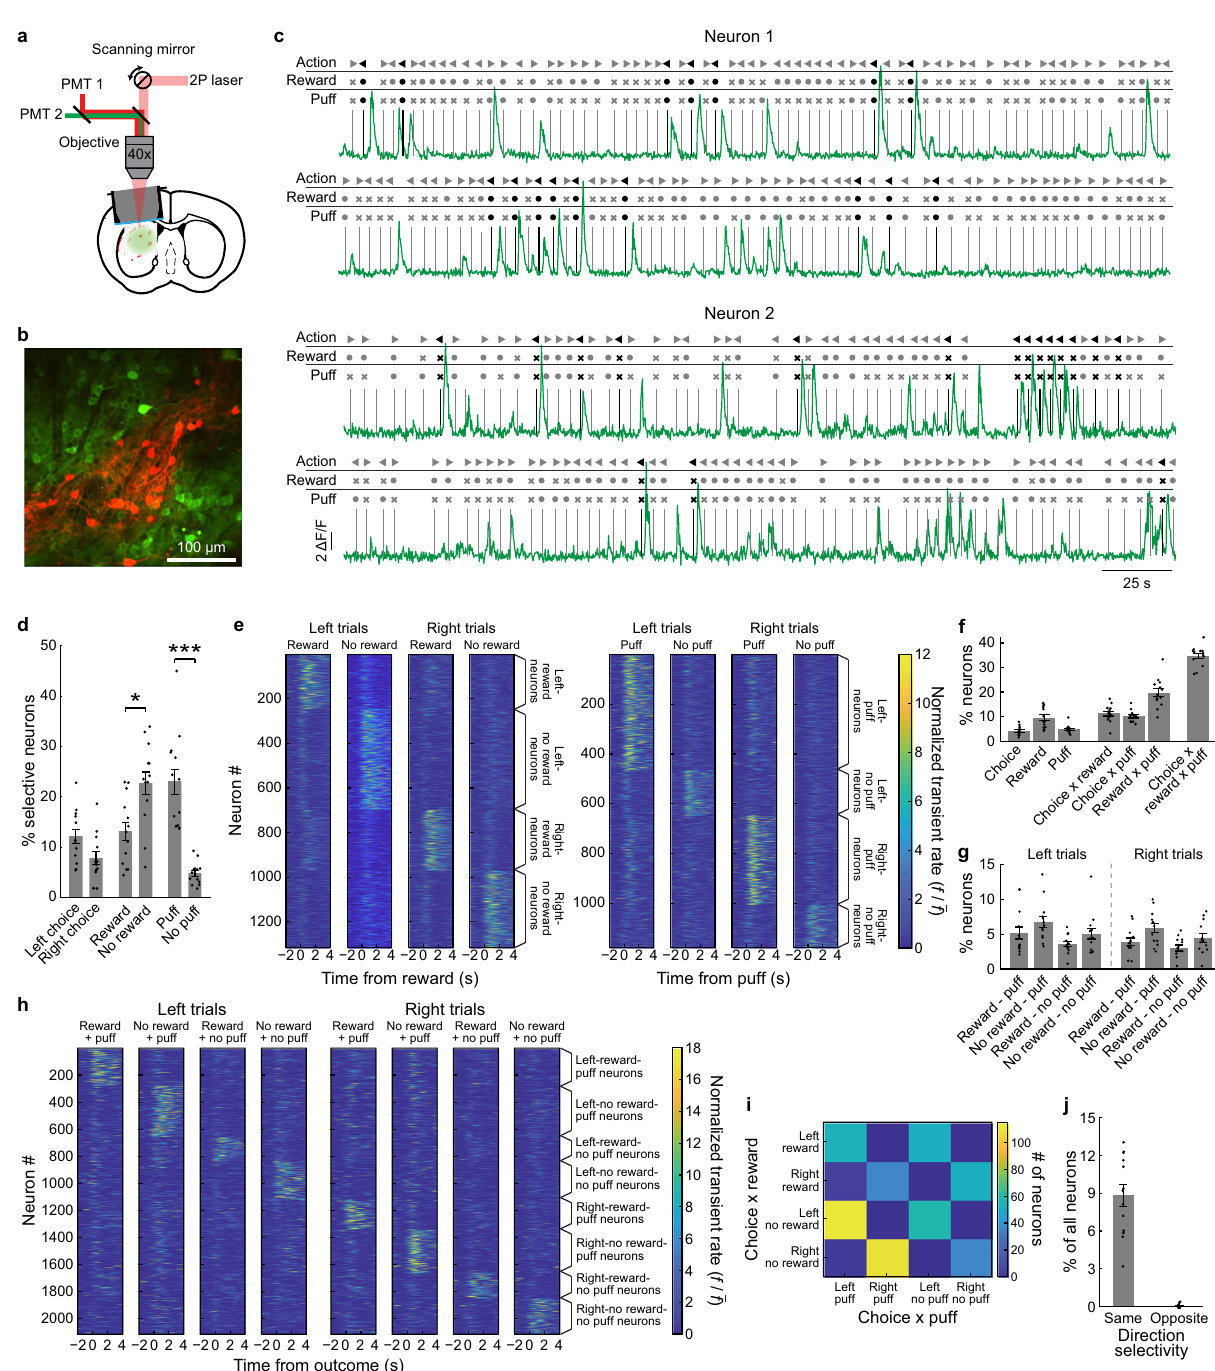
block with a given action – outcome contingency. For neurons with signi fi cant encoding of action – outcome contingencies, we quanti fi ed the percentage of trials with these actions and outcomes in which a Ca ++ transient occurred. Neurons that were active speci fi cally for an action- reward combination were more active in the fi rst such trial after a switch as compared to other trials with the same action and outcome (Supplementary Fig. 2k, p <0.005, t = 3.51, df = 12, repeated measures t - test), as were neurons active speci fi cally for an action – puff combination ( p <0.001, t = 6.66, df = 12). No difference was observed for neurons that were active for a given action and the omission of reward or puff. Next, we asked whether action – reward and action – puff contingencies were represented by separate or overlapping